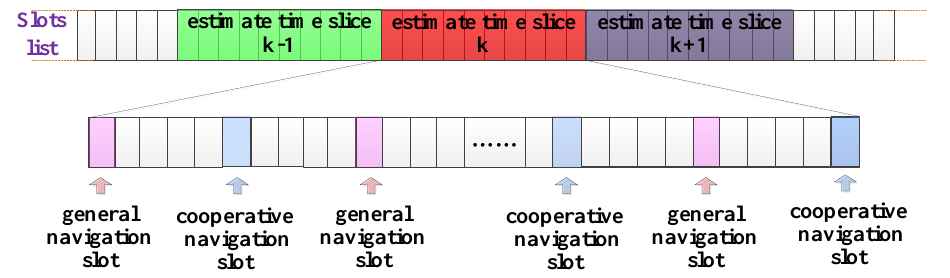
Figure 5. Estimate period and arrangement of navigation slots.